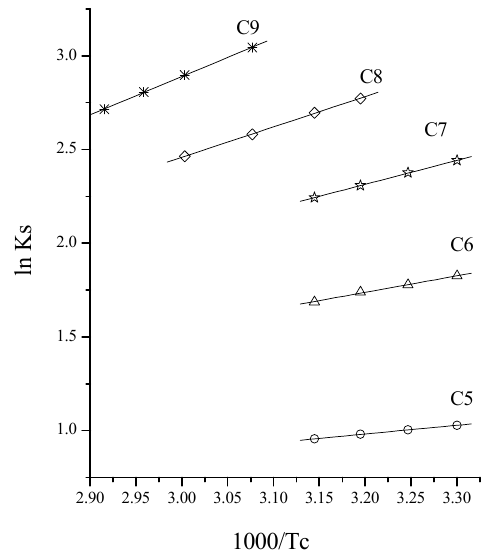
Figure 8. (ln Ks) versus (1000/Tc) for n -C 5 - n C 9 mixture in boehmite for the temperature range of 30–70 °C.